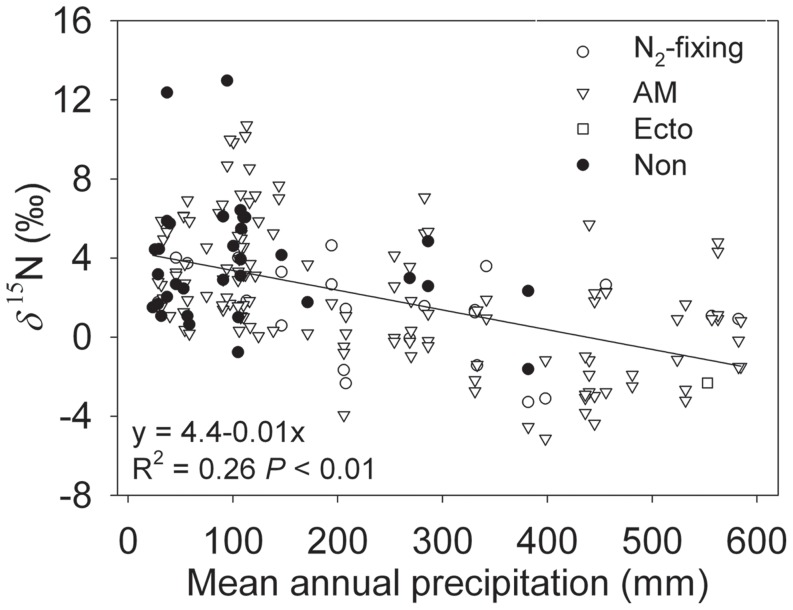
Plant δ
15N values (N2-fixing, open circles; AM, open triangles; Ecto, open squares; Non, filled circles) as a function of mean annual precipitation.Linear regression equations, R
2 and P values are provided.